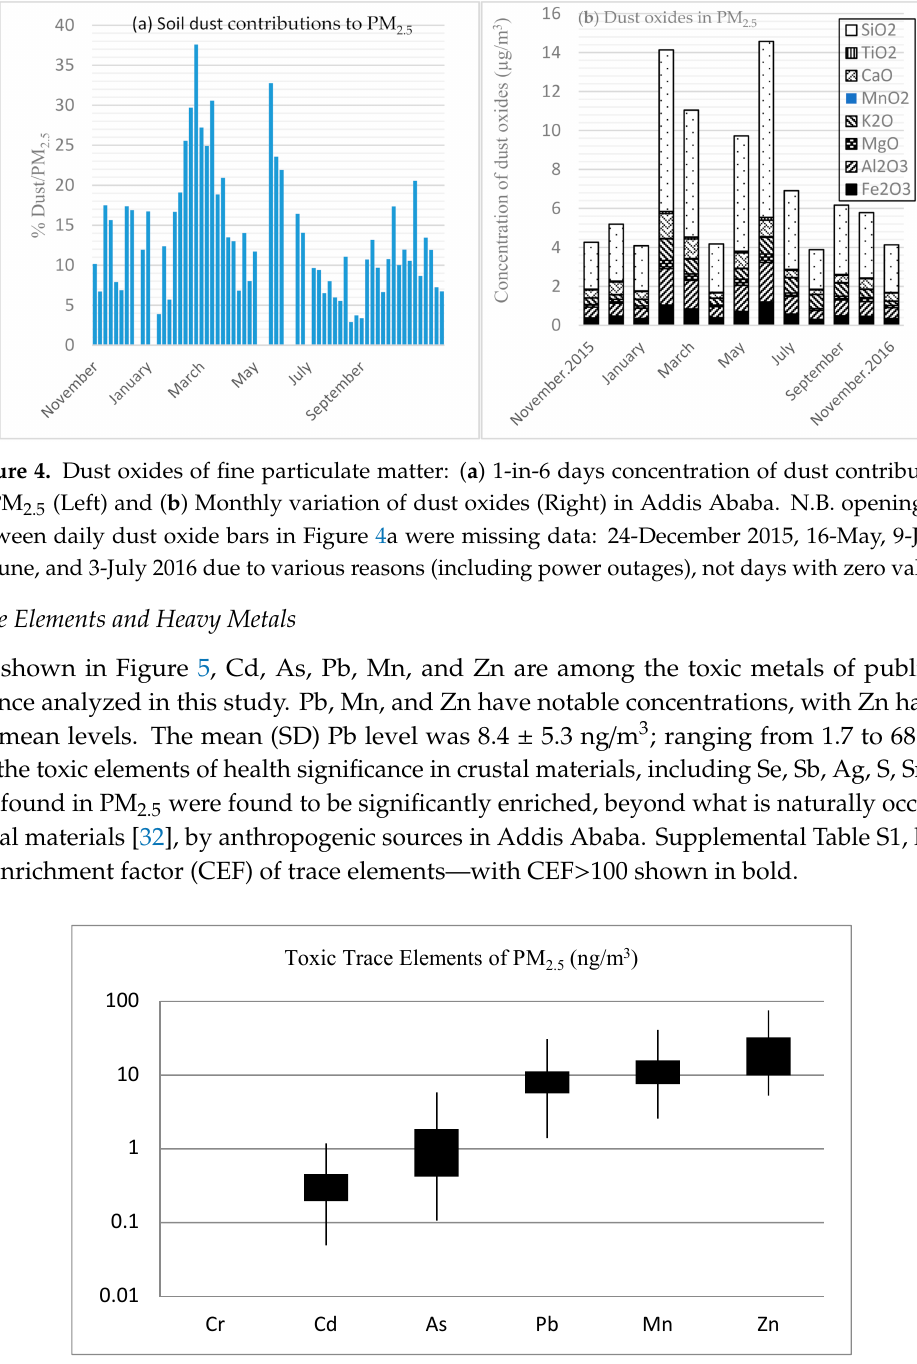
Figure 5. Concentration of toxic trace elements of PM 2.5 in central Addis Ababa, Ethiopia.